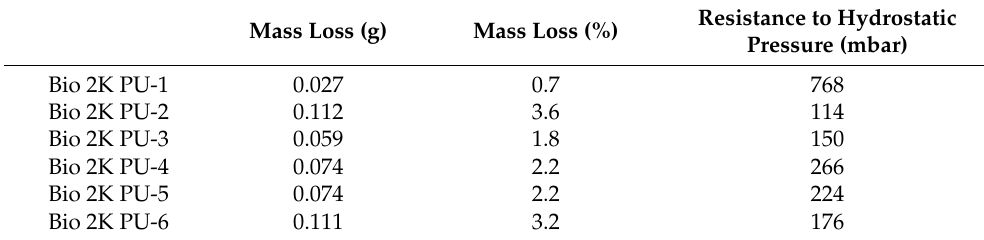
Table 6. Mass loss and the resistance to hydrostatic pressure after abrasion.